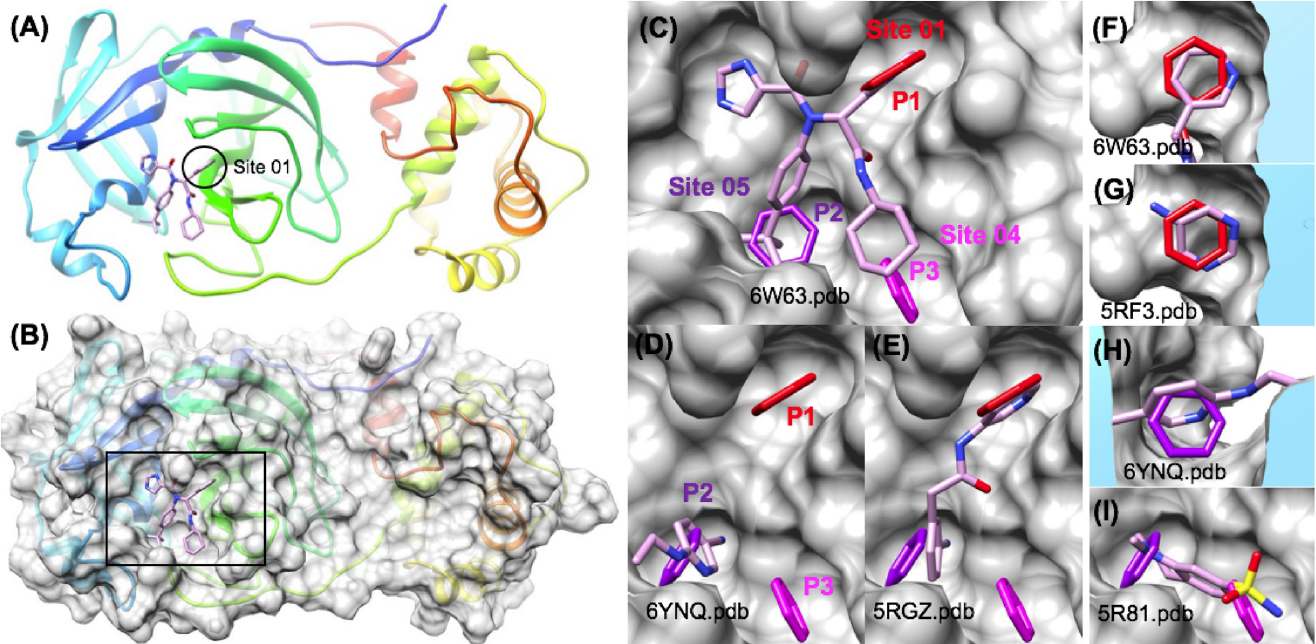
Fig 6. Pharmacophore mapping successfully identifies Nsp5 Mpro inhibitor substrate recognition site pharmacophores. The crystal structure of Nsp5 Mpro (6W63.pdb) bound to a broad spectrum non-covalent inhibitor is shown using ribbon diagram with rainbow coloring (A) and is shown with a transparent gray surface in (B). The three protease P1, P2, and P3 substrate recognition binding pockets were identified with favorable aromatic pharmacophores as shown for Site 01, Site 05 and Site 04 respectively (C). Several crystal structures of other fragment ligands (6YNQ.pdb, 5RGZ.pdb, 5RF3.pdb, 6YNQ.pdb, 5R81.pdb) independently confirm the position of the Site 01 (P1) and Site 05 (P2) pharmacophores shown in (D) thru (I).